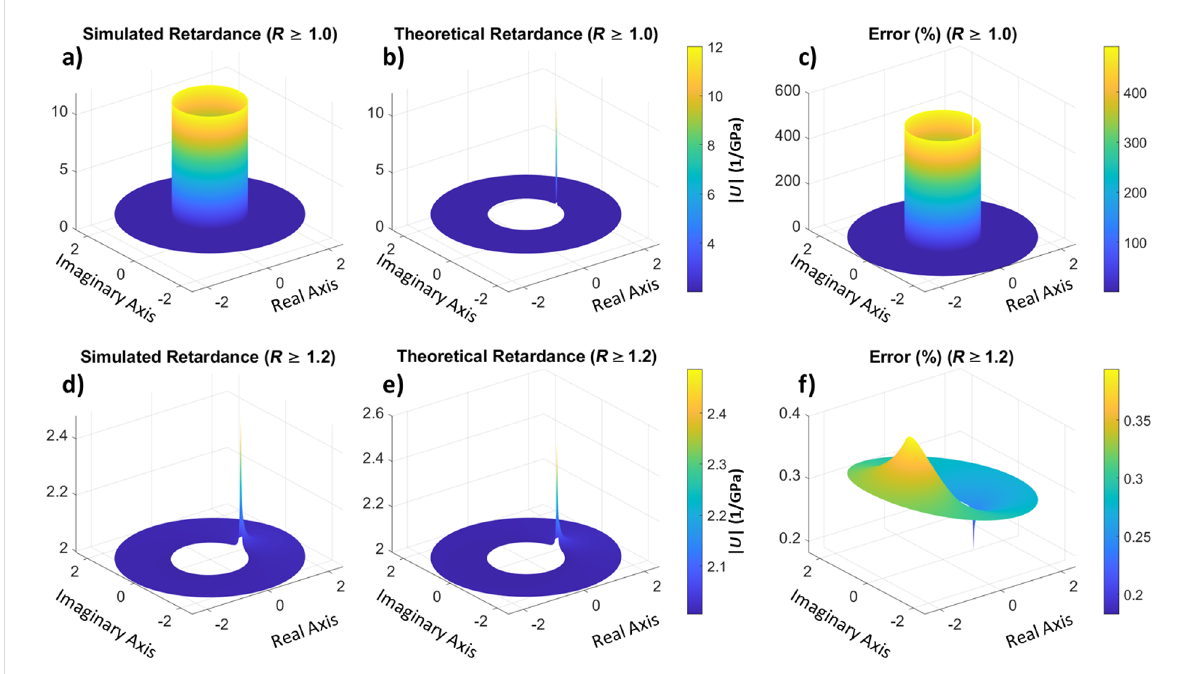
Figure 9: (a, d) Amplitude of simulated retardance in the z -domain for an AFM simulation. (b, e) Retardance of the material calculated from the theo- retical values. (c, f) Error between the simulation and the theoretical calculations. The information presented in the figures in the top and bottom rows is the same, except that for the bottom row the images only include data for circles with a radius greater than 1.2, while the top row starts from R = 1.0. We observe good agreement and similar issues at the unit circle as in Figure 4.